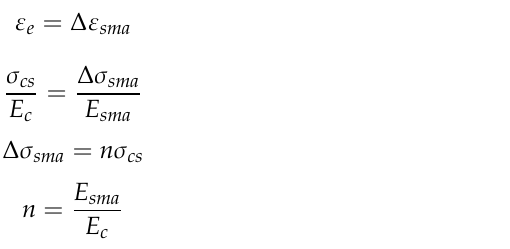
Figure 9. Elastic shortening due to recovery stress of Fe ‐ SMA.